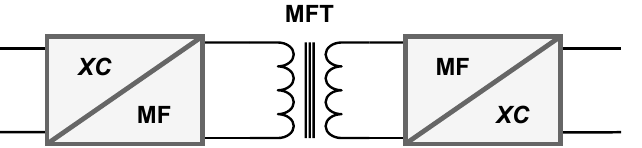
Figure 2. Working principle of SST. Different configurations can be obtained depending on the employed power electronics